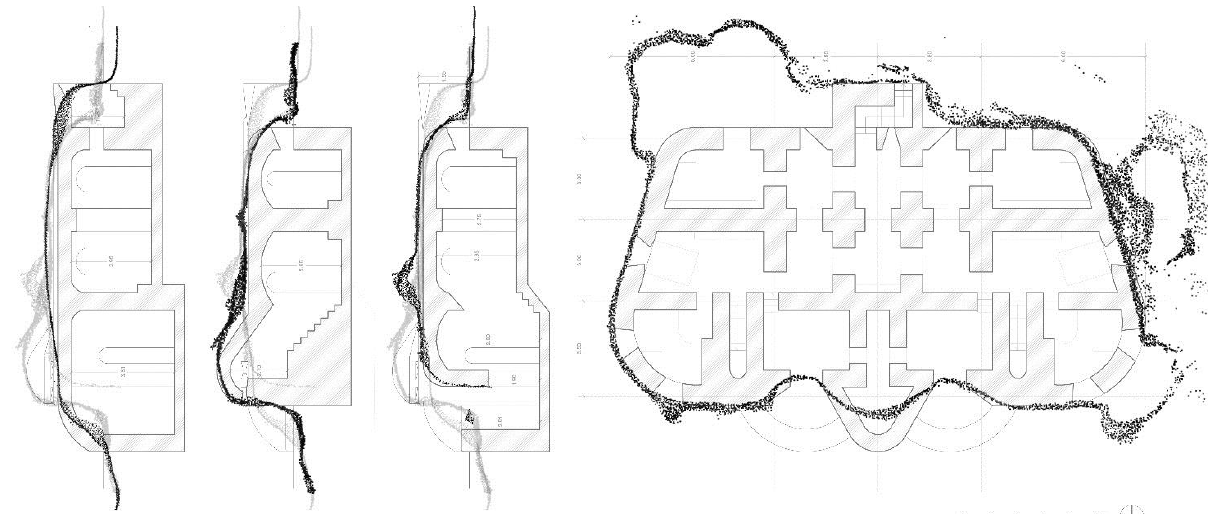
Figure 10. Top view and sections of the bunker CG-BK04.elc combining the photogrammetric work with traditional drawings. The irregularity of the reality, almost conforming a drawing of a natural or vegetal element, contrasts with the orthogonality and the precision that, without a doubt, established the original references of the 204m2 during the construction. The defense zone in the front part (first division, where pits, loopholes, and hatches stairs are located) is distinguished of the refuge area in the back, where it descends by means of a stairway (drawings: authors)